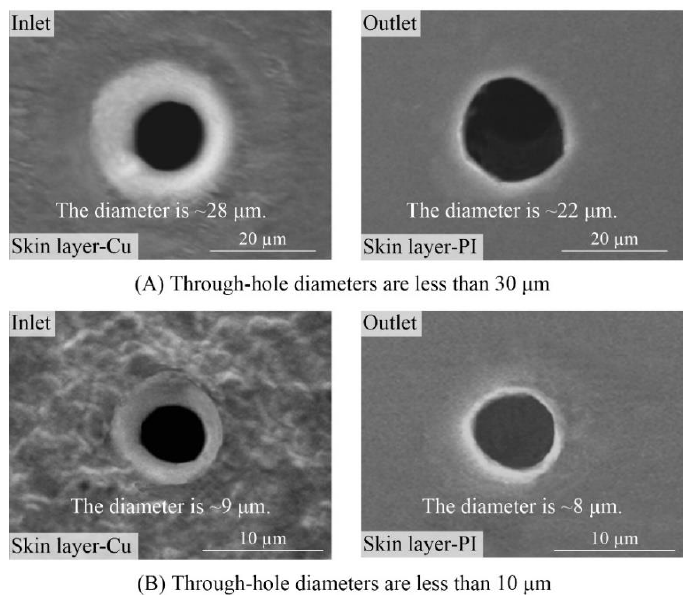
Figure 8. SEM images of through-holes in single-sided board with the laser wavelength of 355 nm (( A ) Energy of 0.022 mJ, 50 pulses; ( B ) Energy of 0.005 mJ, 50 pulses).